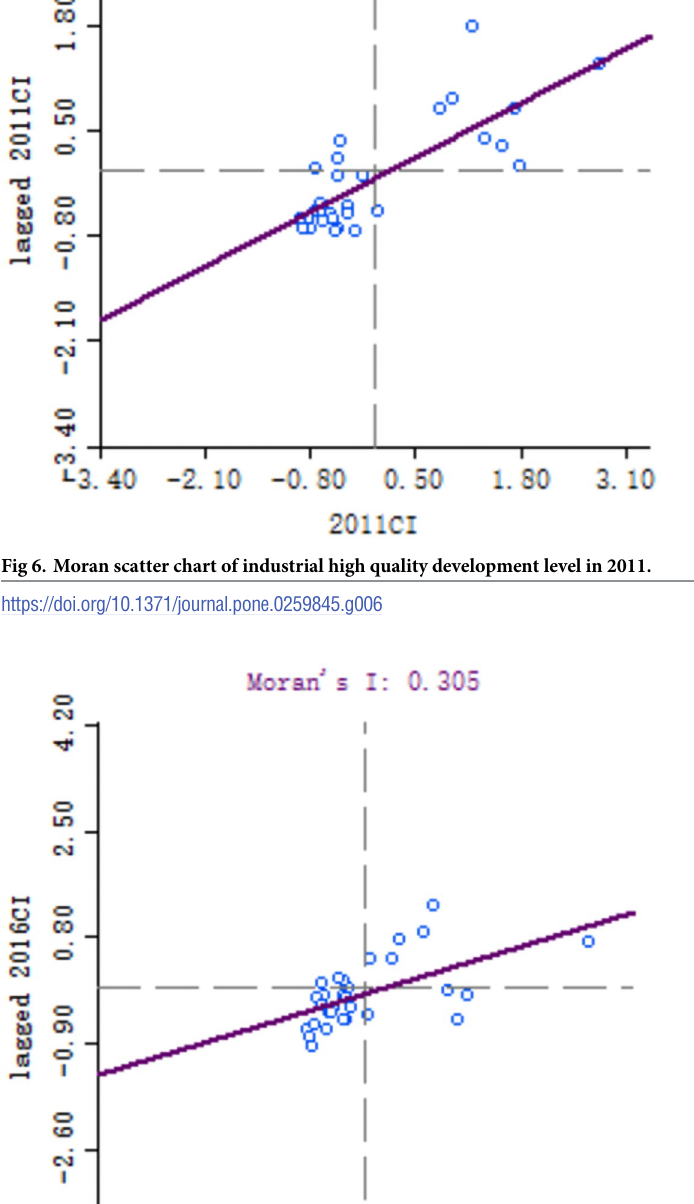
PLOS ONE | https://doi.org/10.1371/journal.pone.0259845 December31,